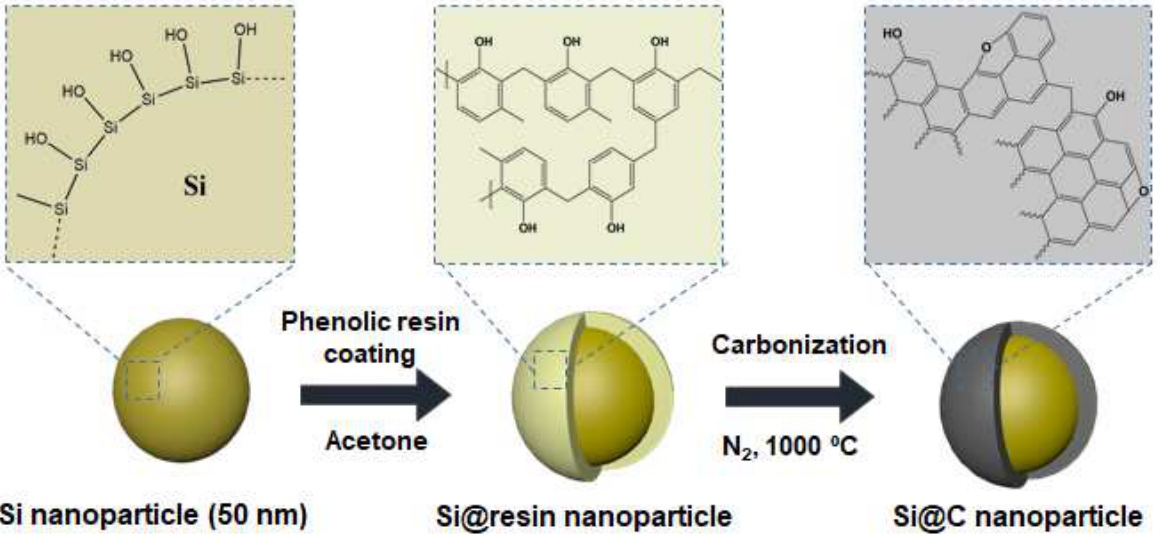
Figure 1. Schematic process of the phenolic resin-derived carbon coating method on Si NPs.